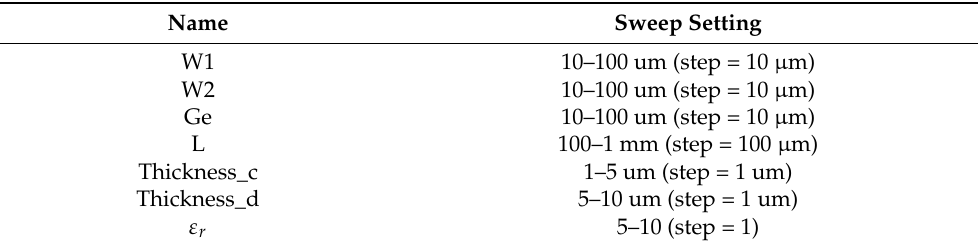
Table 13. Sweep setting of coupled transmission lines.